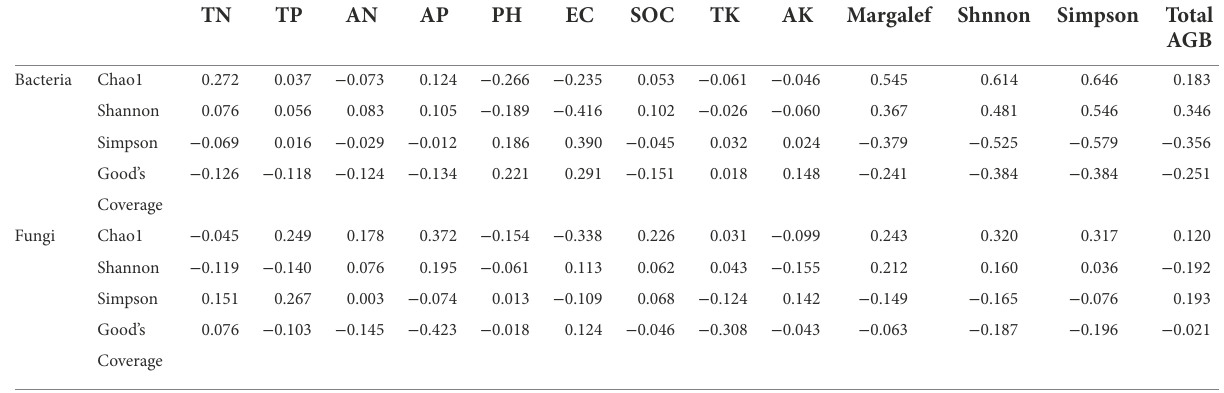
TABLE 4 Spearman rank correlation analysis of soil bacteria and fungi with plant species diversity and soil properties.